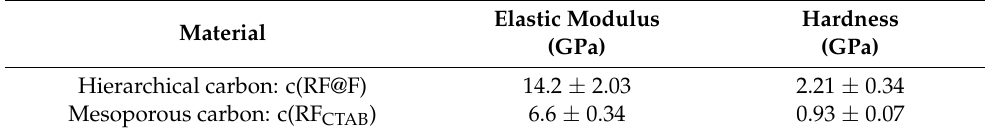
Table 1. Elastic modulus and hardness of porous carbon